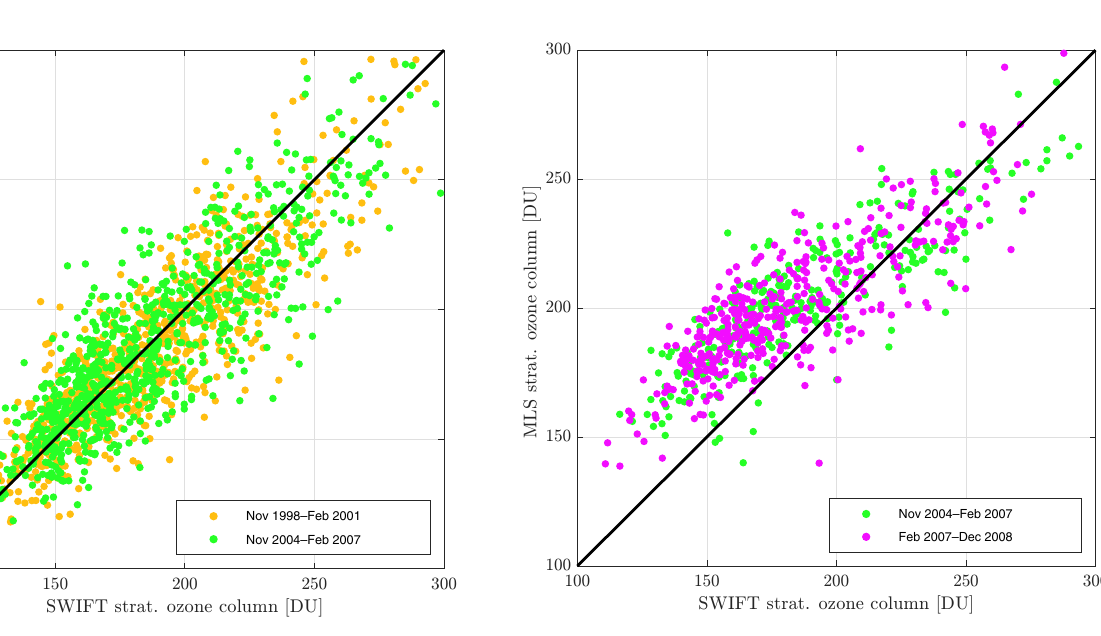
Figure 8. SWIFT vs. ATLAS scatter plot of daily averaged strato- spheric ozone columns (15–32km) over Potsdam. The orange and green dots correspond to the two training data periods in Fig. 7.